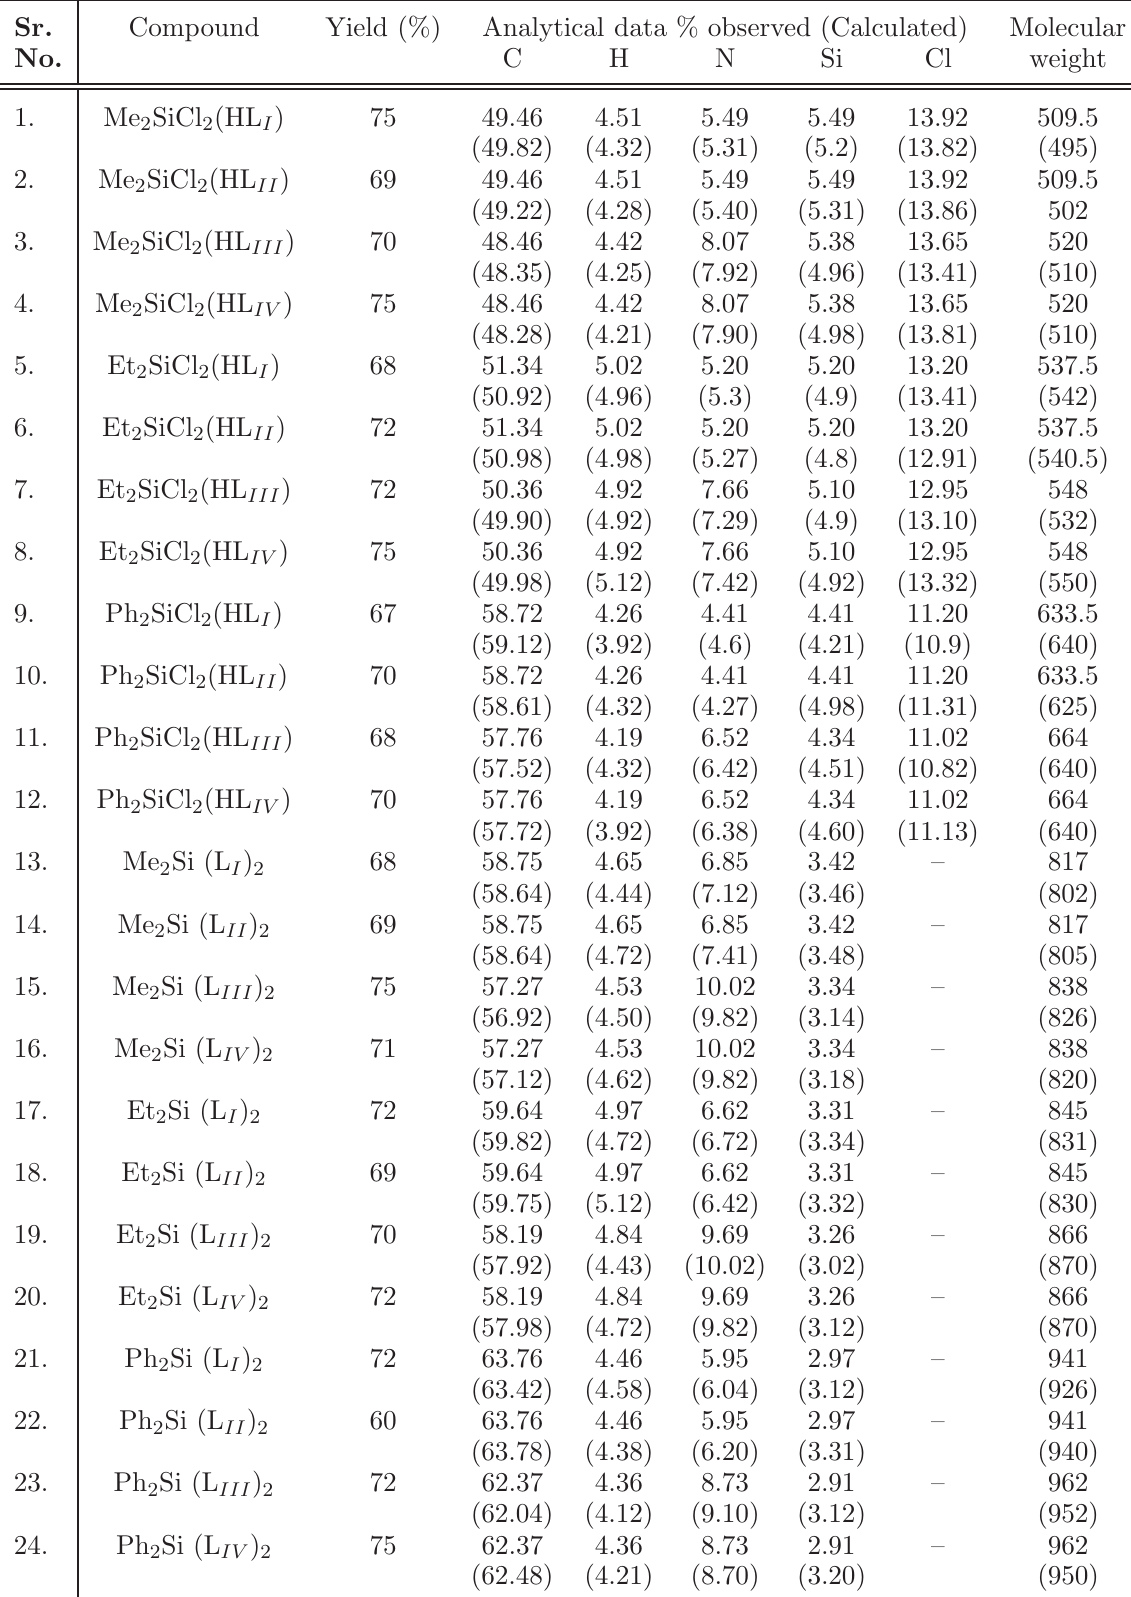
Table 1 Analytical data of dichlorodiorganosilane and diorganosilicon